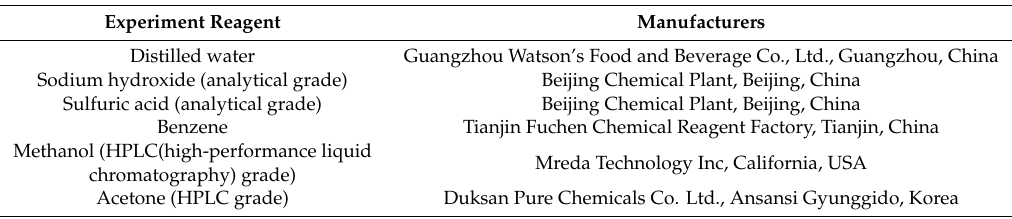
Table 1. Experiment